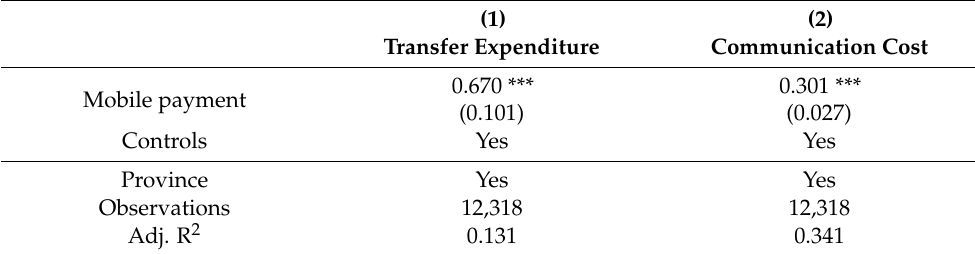
Table 10. Mechanism analysis: increasing social interaction.